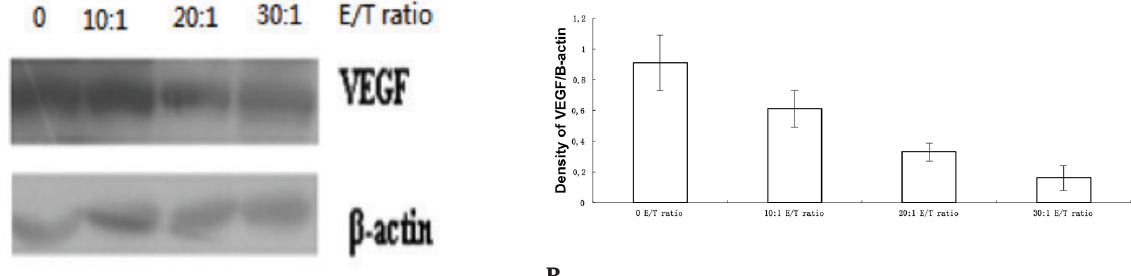
A Figure 4: A shows VEGF over-expression in NCL-H157 treated by CIK with western blotting analysis. In order to elucidate the pathway leading to proliferation, we examined the activation of VEGF, which was reported to initiate NCL-H157 generation by various stimuli. NCL-H157 treated with CIK were analyzed for the enzymatic activity by western blot. The expression of VEGF was not activated after CIK treatment in NCL-H157 was down-regulated. The activity of VEGF had significantly changed. B shows densitometric analysis of the levels of VEGF by an image analysis system. (n=6. Mean±SD. *P<0.01 vs control group) (ANOVA with subsequent multiple comparisons test)